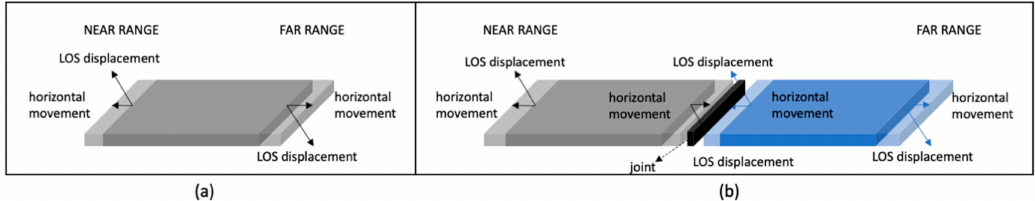
Figure 18. Sketches showing the mechanism of cyclic temperature correlation ( a ) on the roof of Zhuhai Passenger Terminal shown in Figure 14b and ( b ) bridges and roads shown in Figure